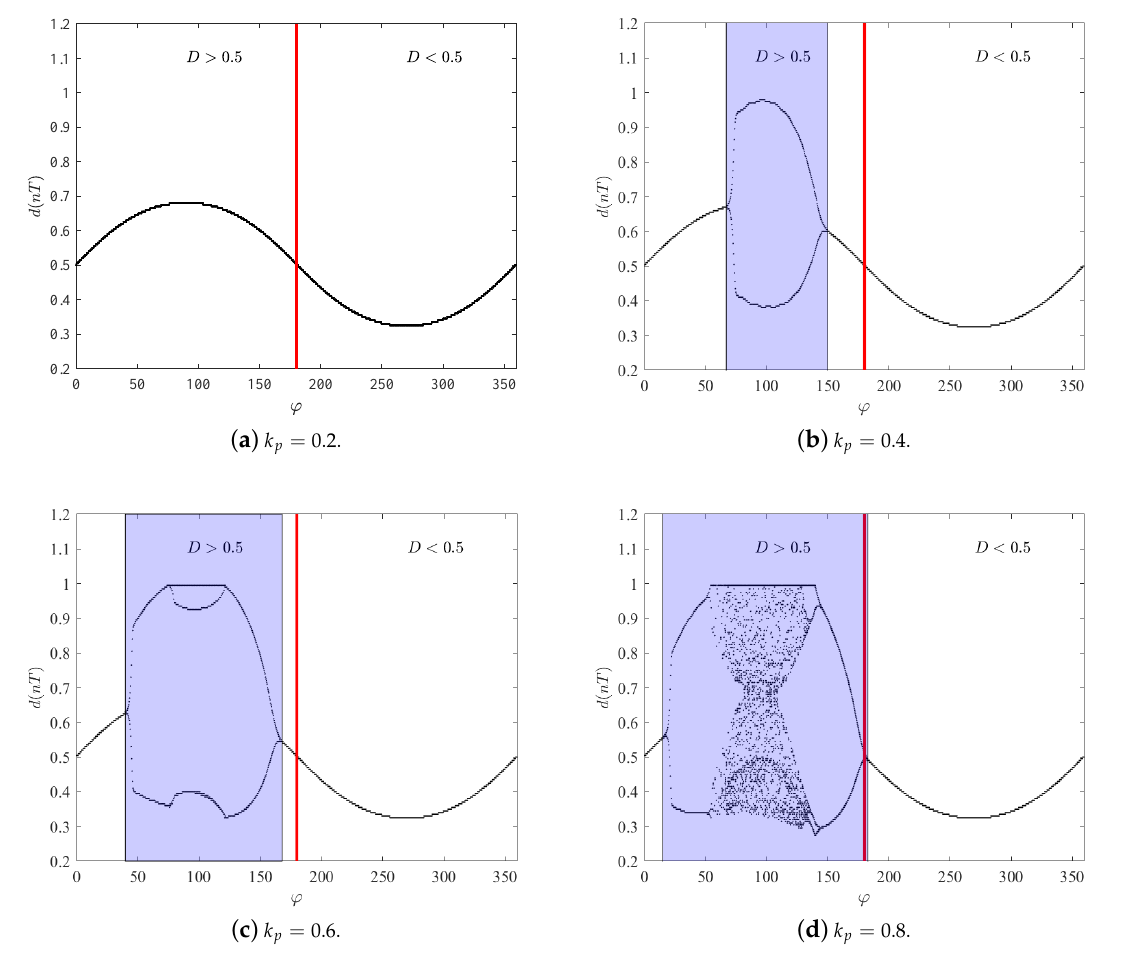
Figure 5. Waveforms of the duty cycle d ( nT ) at steady-state operation in terms of the phase angle in [ ◦ ] for different values of k p and for V M = 2